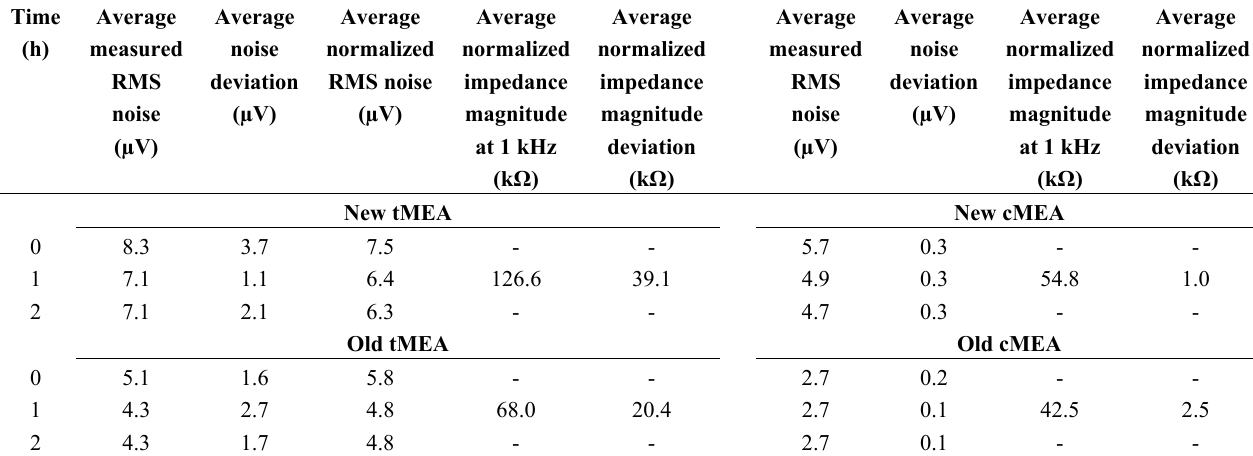
Table 1. Average RMS noise and impedance magnitudes (area-normalized) comparison of three new (unused) and three old (previously used in biological measurements) tMEAs and cMEAs at three different times after filling the MEAs with medium.